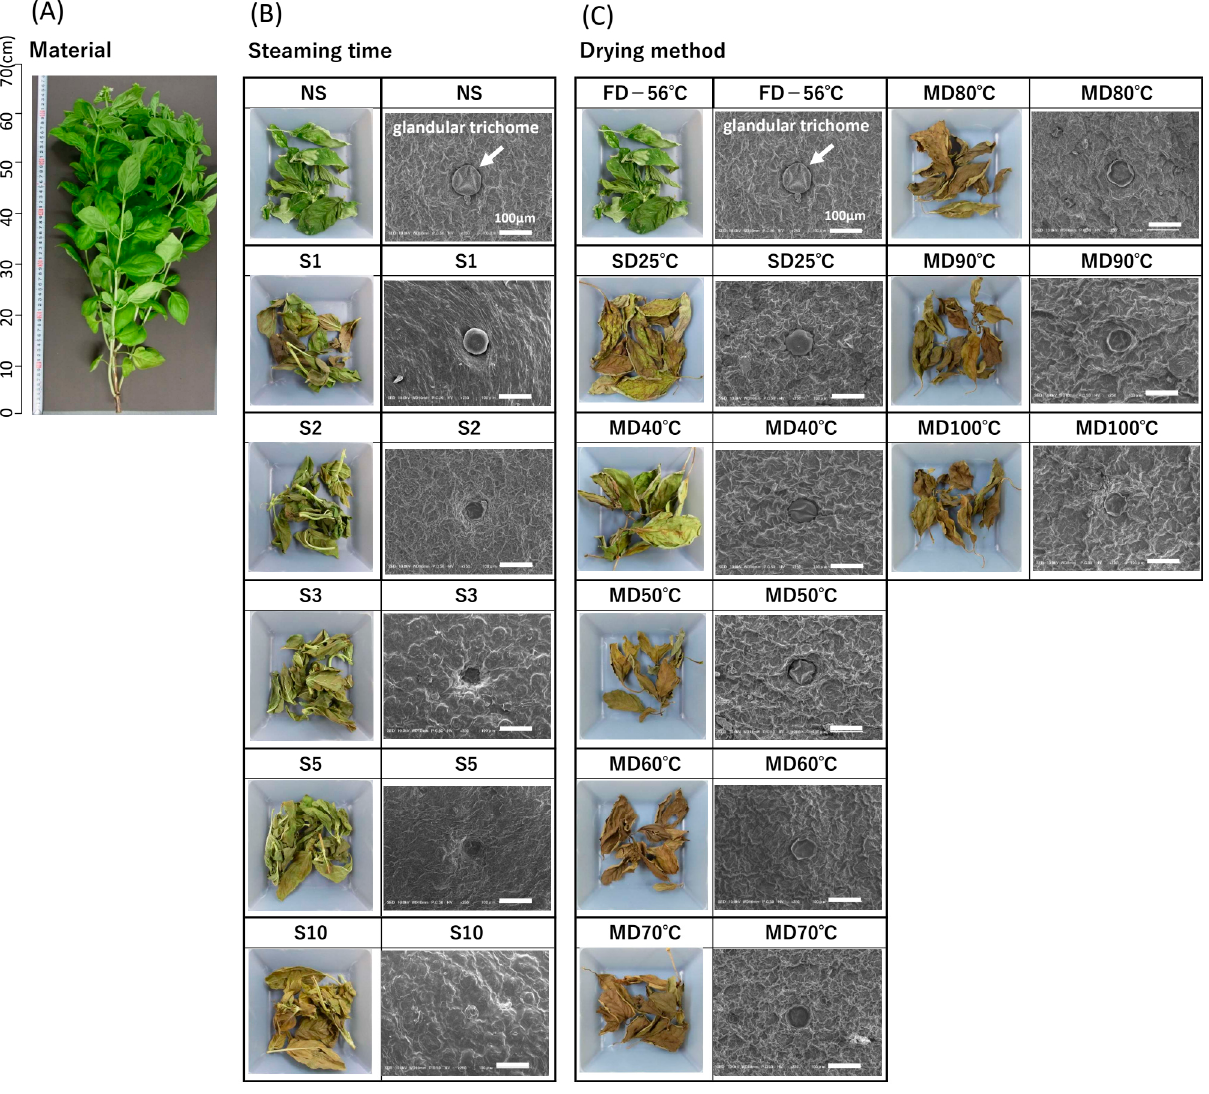
Figure 1. Digital camera and SEM images of Ocimum basilicum cv. ‘Genovese’. ( A ) Experimental